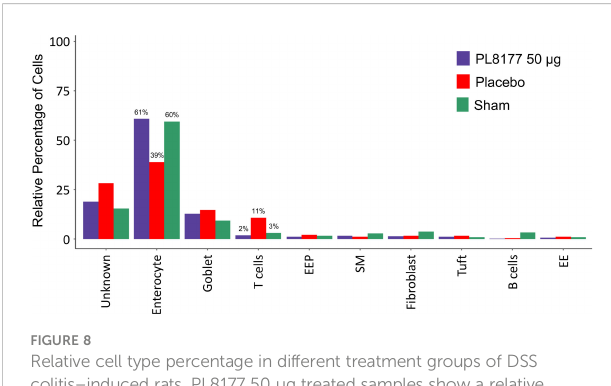
FIGURE 8 Relative cell type percentage in different treatment groups of DSS colitis – induced rats. PL8177 50 µg treated samples show a relative increase in the number of enterocytes and decrease in T cells compared to placebo. DSS, dextran sulfate sodium; EE, enteroendocrine; EEP, enteroendocrine progenitor; SM, smooth muscle.